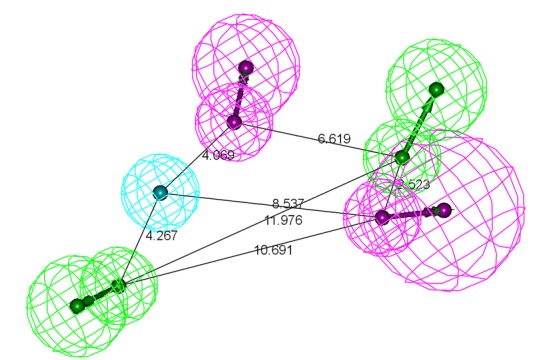
Receptor based pharmacophore model (Hypo-1) of PTP1B allosteric inhibitors generated by LigandScout.Pharmacophore features are: hydrogen-bond acceptor (green), hydrophobic (cyan), and hydrogen-bond donor (magenta).